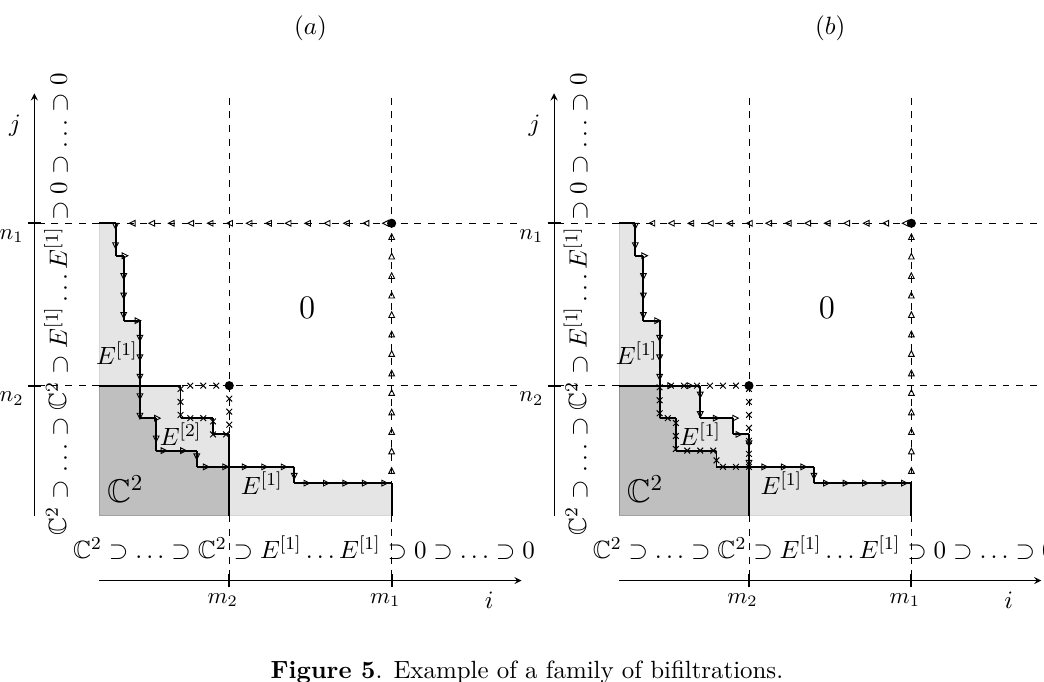
Figure 5 . Example of a family of bifiltrations.